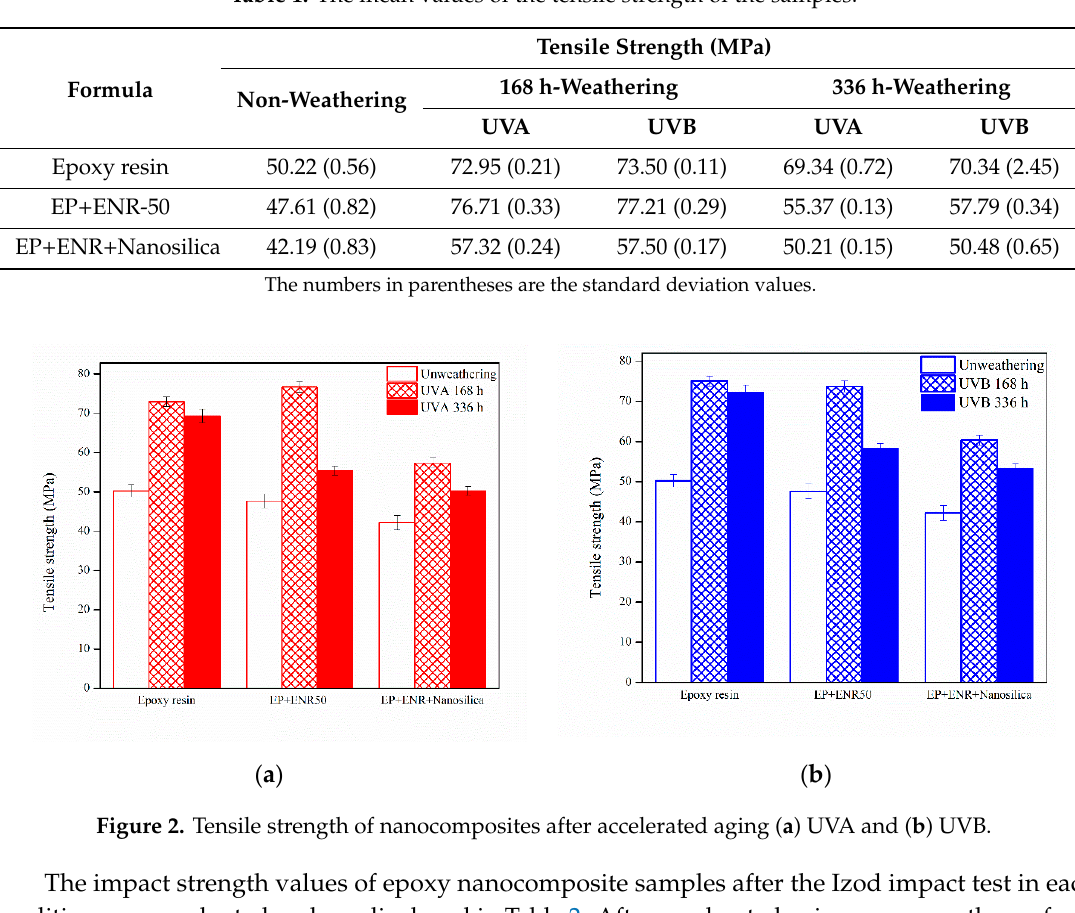
Table 2. The mean values of the impact strength of the samples.